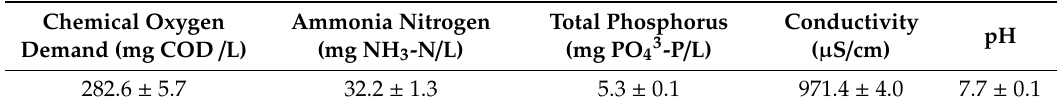
Table 1. Composition of synthetic wastewater for the submerged direct contact membrane distillation (SDCMD)